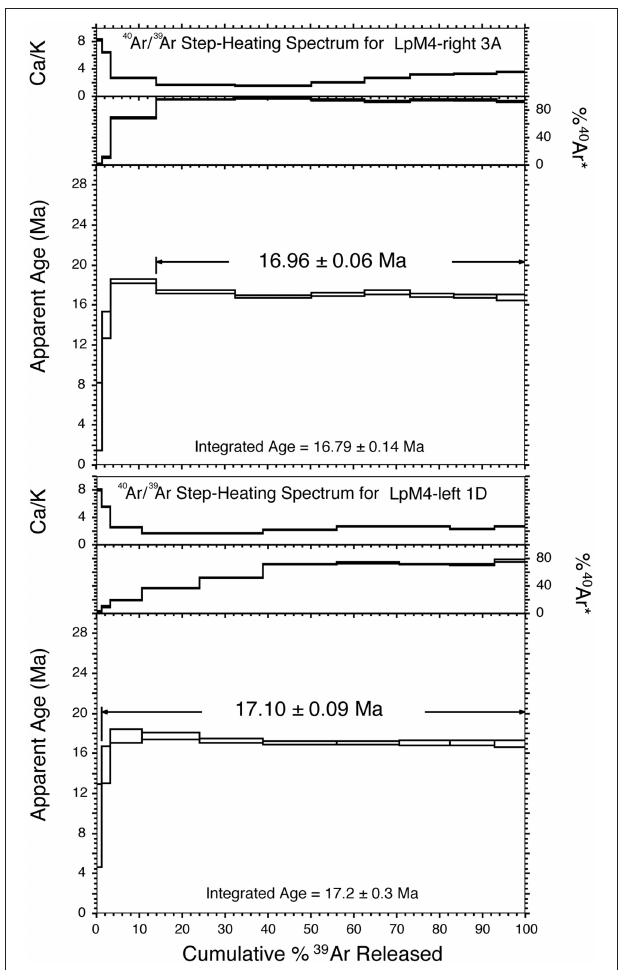
FIGURE 4 | 40 Ar/ 39 Ar incremental-heating spectra for samples LpM4-right 3A ( top ) and LpM4-left 1D ( bottom ). Reported 40 Ar/ 39 Ar dates are weighted age determinations and errors at the 2- σ confidence level. Both analyzed samples produced well-constrained plateau ages, which are statistically indistinguishable from each other. Plateau steps are indicated by lines ending in